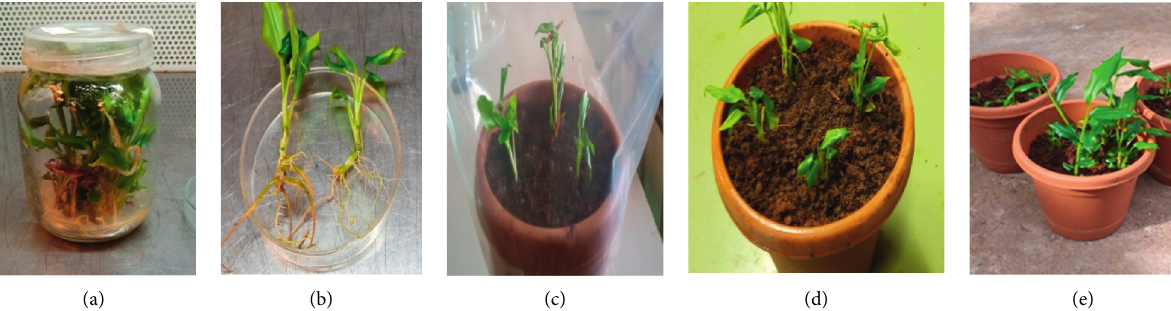
Figure 5: Acclimatization of in vitro grown plantlets of A. corrorima : (a, b) plantlets ready for acclimatization; (c) plantlets in the pot of sterilized forest soil: compost: sand (1:2 :1) covered with plastic; (d) plantlets adapted to the external environment after 10 days of plastic cover; (e) acclimatized plants after two months. Bars �